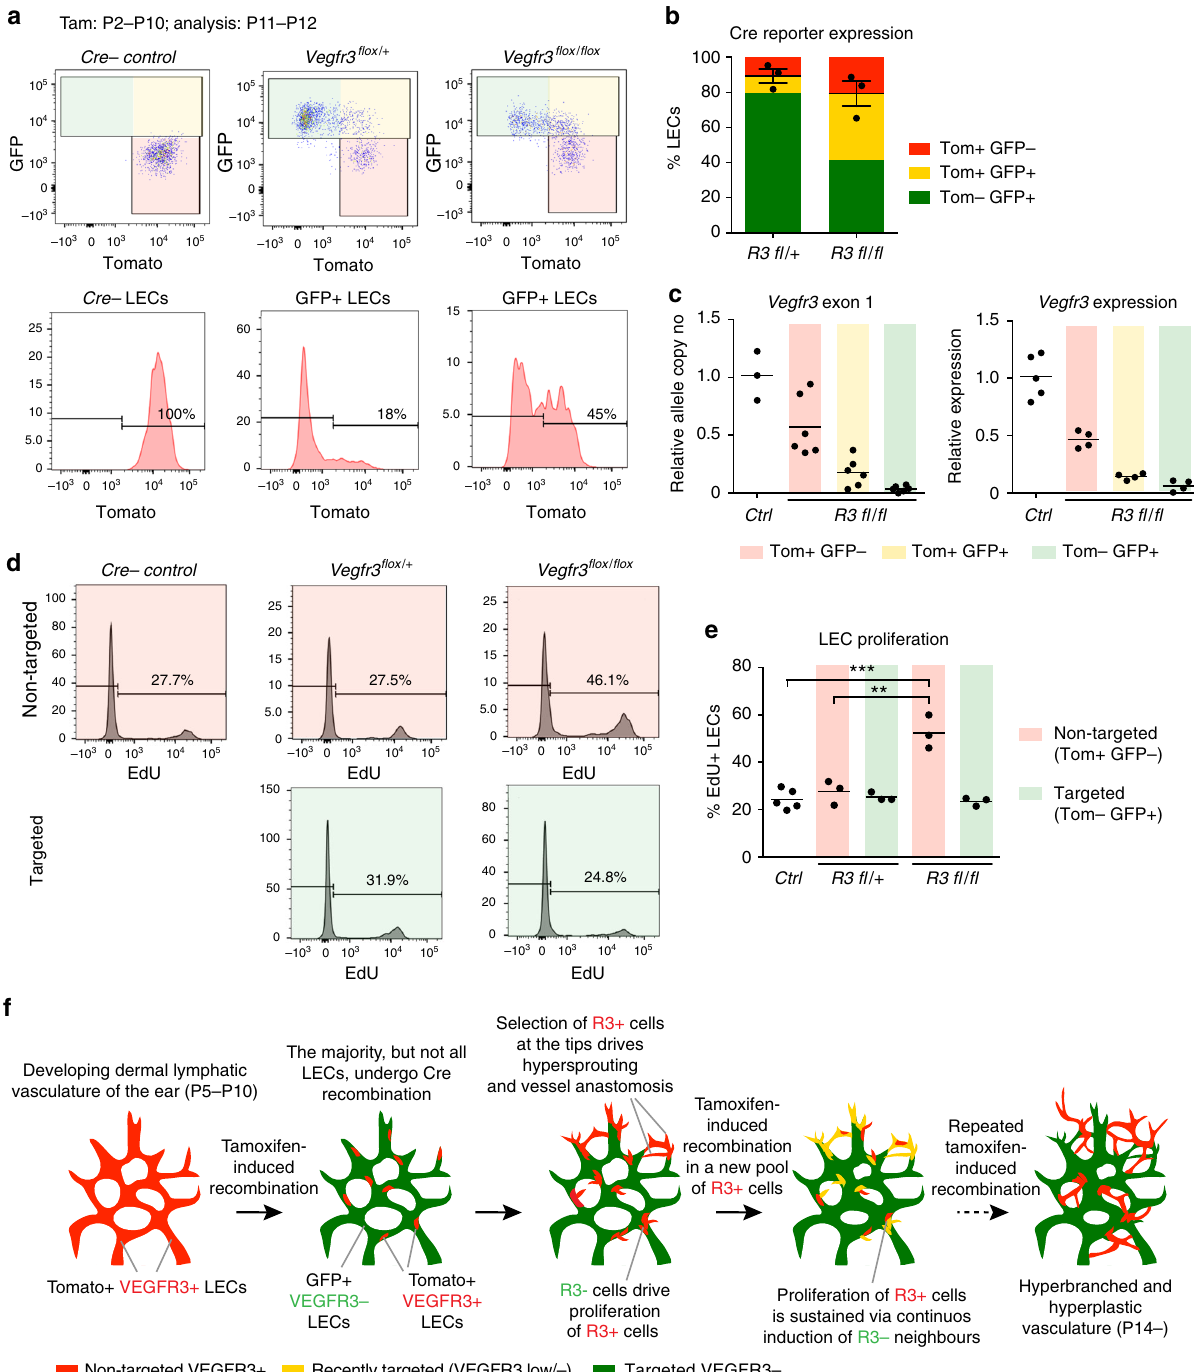
Fig. 4d, e, Supplementary Fig. 5) and in Vegfr3 -de fi cient vessels in vivo (Supplementary Fig.